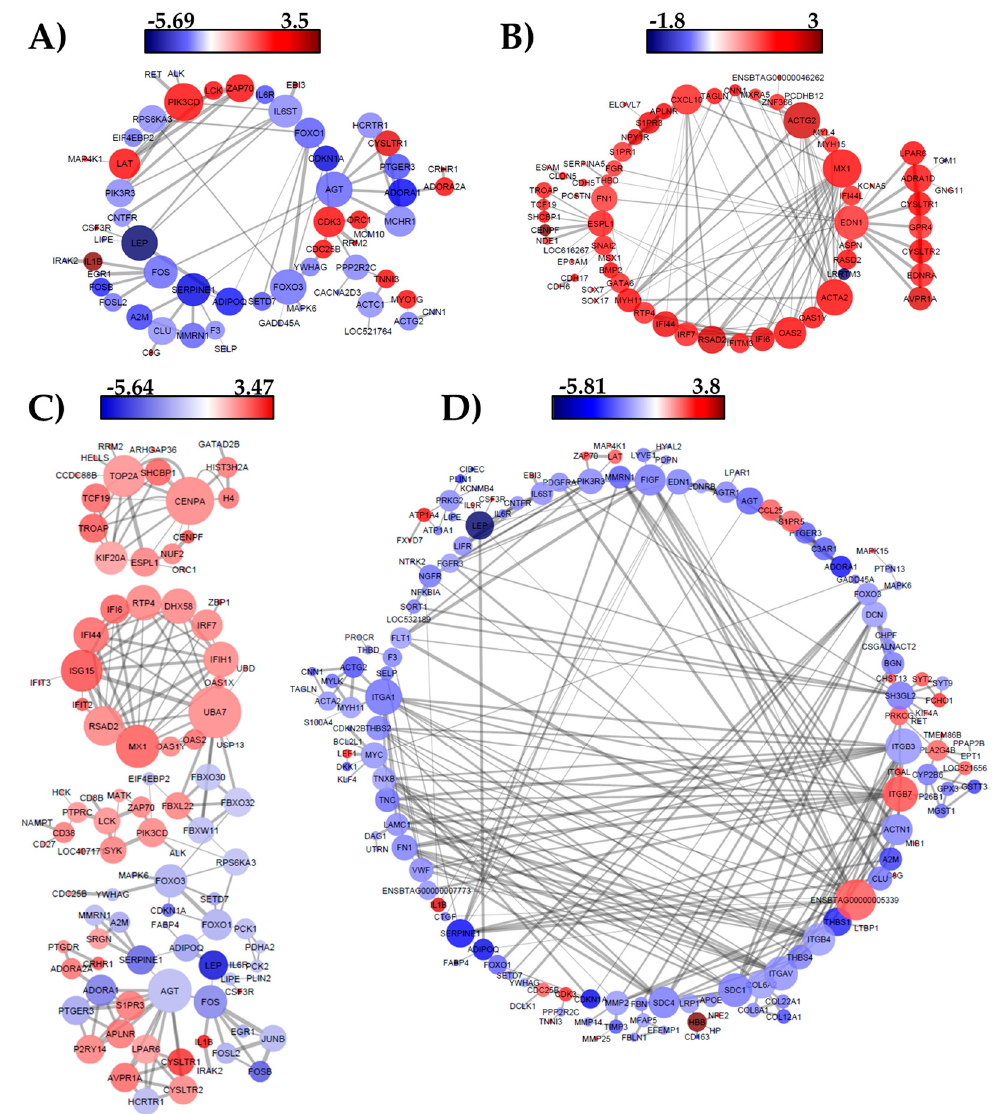
Figure 5. Protein interaction network of DE genes from contrasts. ( A ) 18 vs. 30, ( B ) 30: Low vs. High, ( C ) High: 18 vs. 30, and ( D ) Low: 18 vs. 30. The gray lines are connections (edges) between proteins and the thickness of the lines represents the protein association scores. The circles are proteins in colors according to the logarithmic fold change.